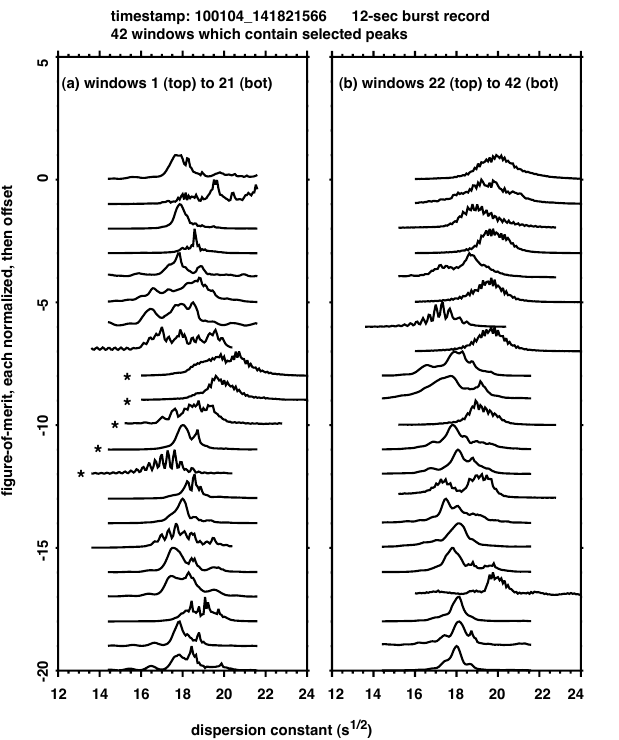
Fig. 11. Iterated figure-of-merit vs. dispersion constant for the burst recording of Fig. 8. Each trace is for a successive analysis window, and only the 42 windows containing at least one selected peak are shown. The five traces marked with an asterisk correspond to the sustained trend in dispersion seen in Fig. 10 above.